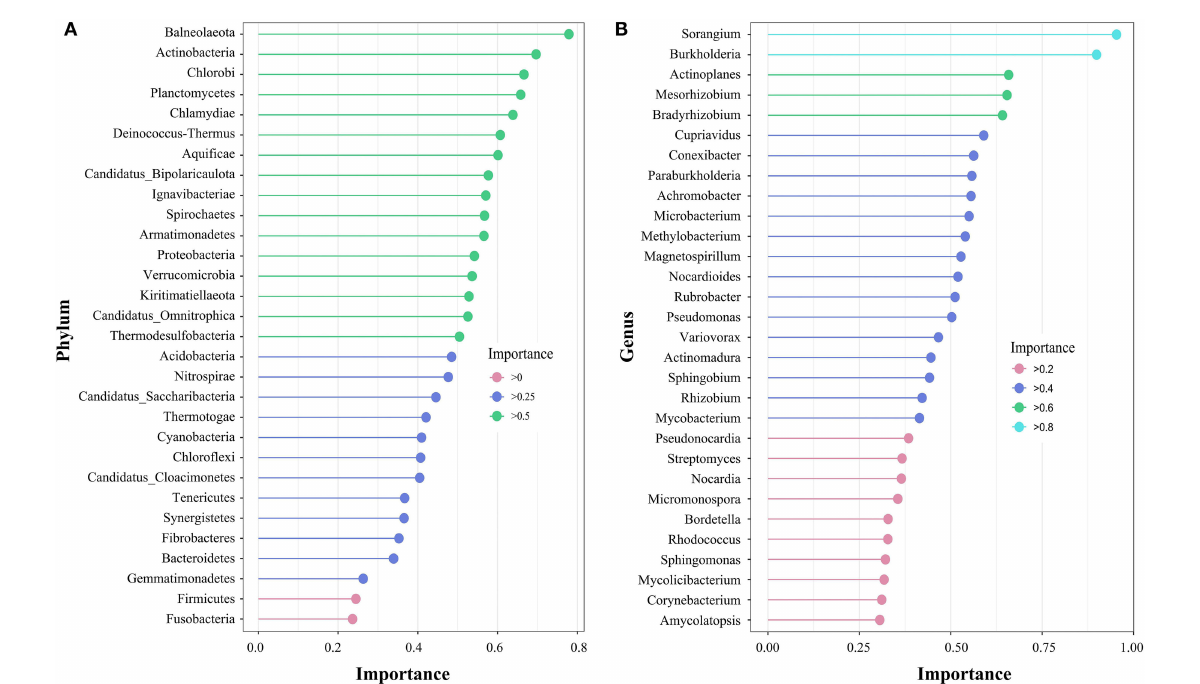
FIGURE4 Species importance point map according to the importance of the top 30 rhizosphere soil microorganisms at the phylum (A) and genus (B) levels on the northern Tibetan alpine